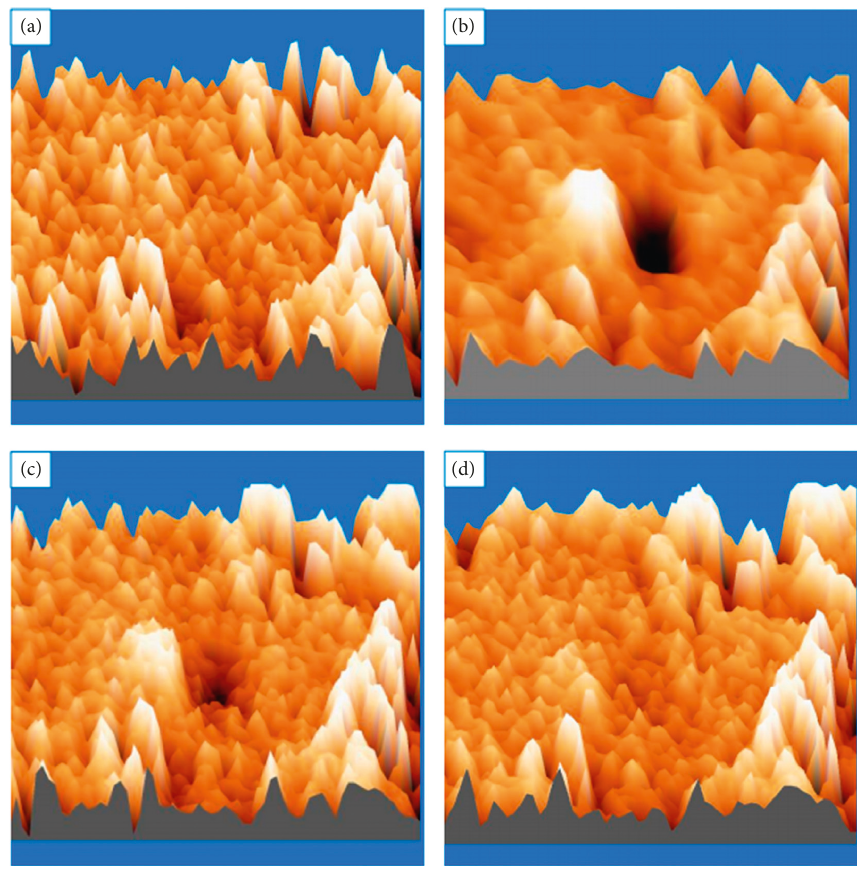
Figure 24: Asphalt micrograph: (a) directly before loading, (b) 163 sec after loading, (c) 350 sec after loading, and (d) 800 sec after loading. The figure is obtained from Qtaish [59] (under the creative commons attribution license/public domain).